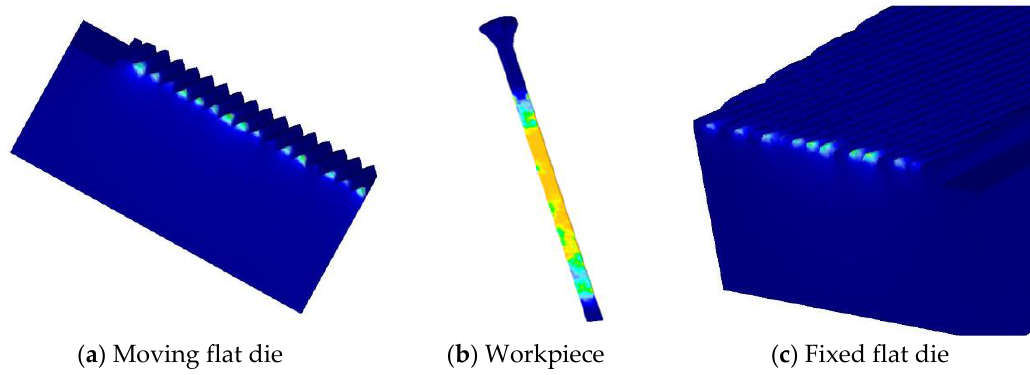
Figure 14. Effective stresses of flat dies and workpiece for cross-section of Figure 13.